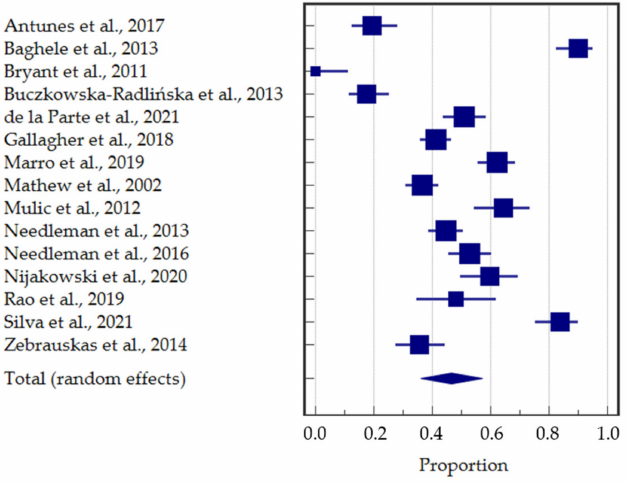
Figure 3. Forest plot presenting the summarised prevalence of dental erosion among physically active